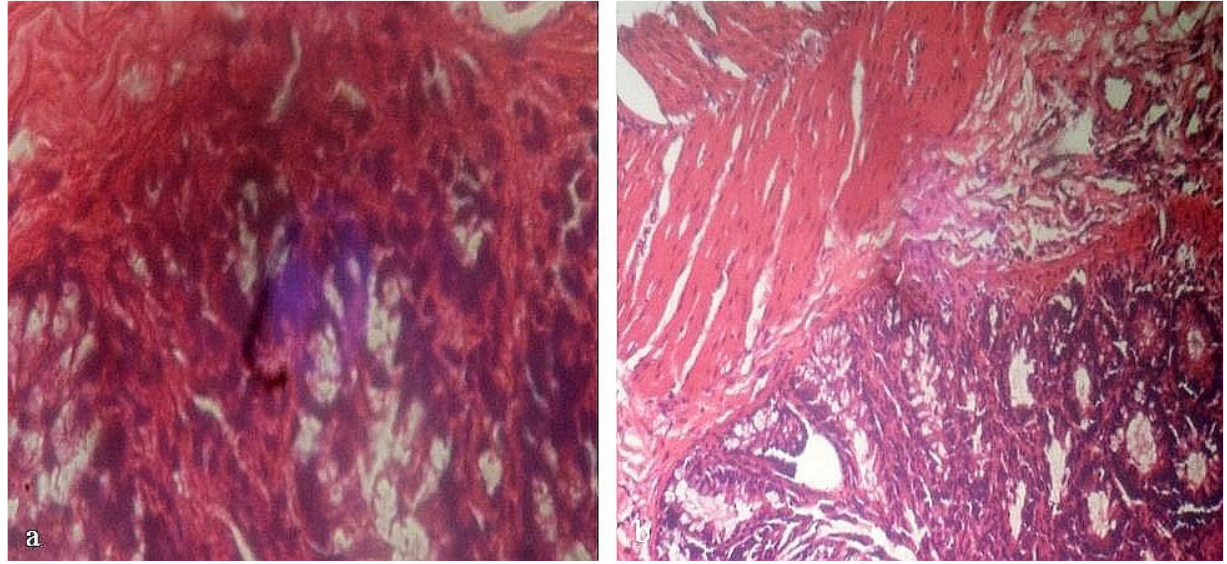
Fig. 2. Induced and treated with 35 mg kg -1 extract. The Photomicrograph shows section of G.I.T. with dense mucosal cells and po rtion of muscular hyperplasia; a) Mag X 300. The lamina propria is thin lying below extensi ve area of muscle hyperplasia; b) Mag. X